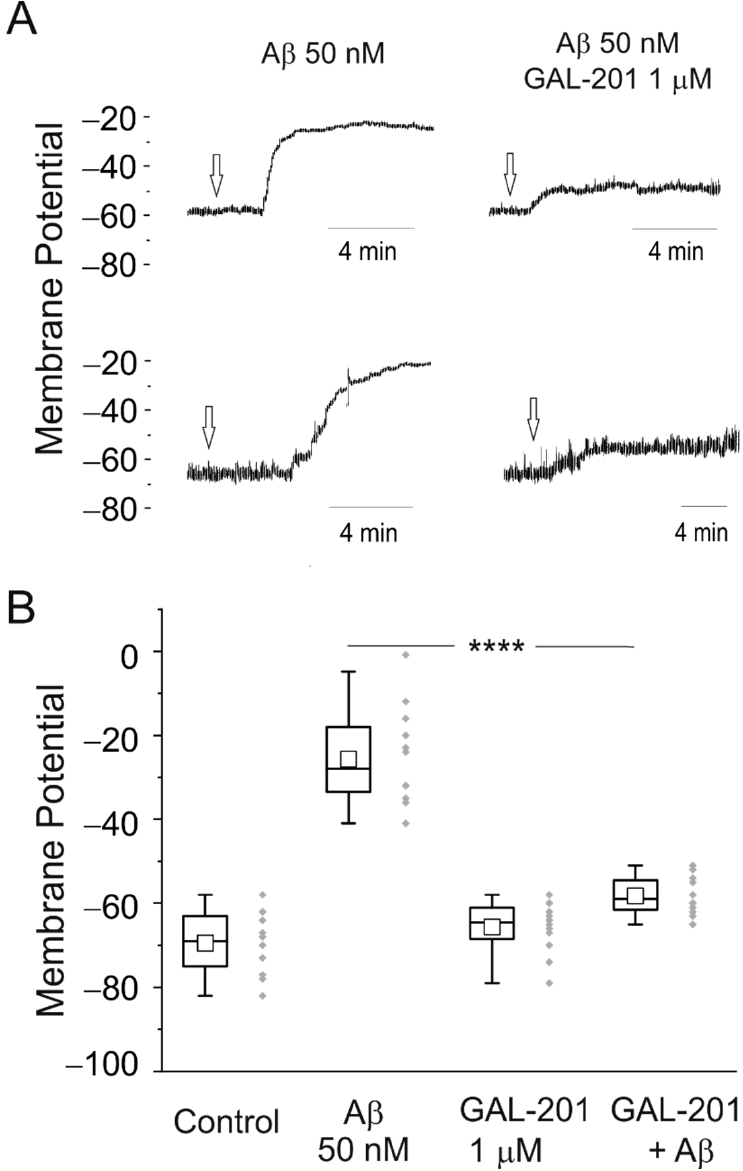
Figure 3. GAL-201 prevents the A β 1-42 − induced depolarization in isolated mouse neonatal hippocampal neurons. ( A ) Examples of time course recordings of membrane resting potential at 23 °C. After monitoring the membrane voltage for a few minutes in control condition, A β 1-42 was perfused (arrows) inducing a strong depolarization (left) while in the presence of GAL-201 (right) depolarization reaches only a few millivolts. ( B ) Average resting potential measurements in control, perfusing 50 nM A β 1-42 plus 1 µM GAL-201 (n = 12 each condition; **** p < 0.0001).